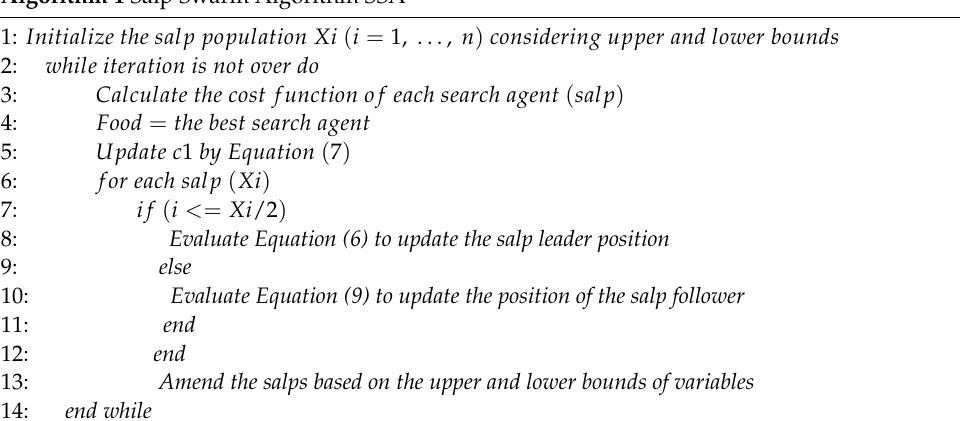
Algorithm 1 Salp Swarm Algorithm